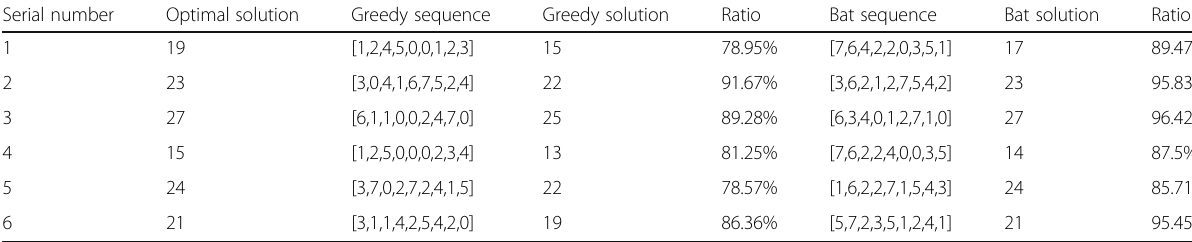
Table 2 Results of greedy algorithm and discrete bat algorithm Serial number Optimal solution Greedy